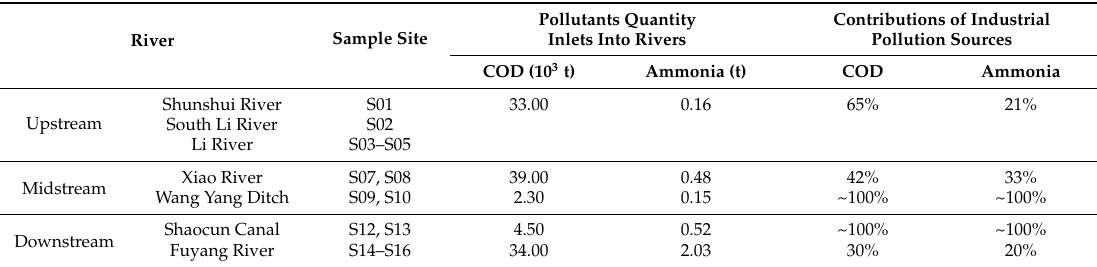
Table 1. Analysis of the point and non-point pollution in the Ziya River Watershed.